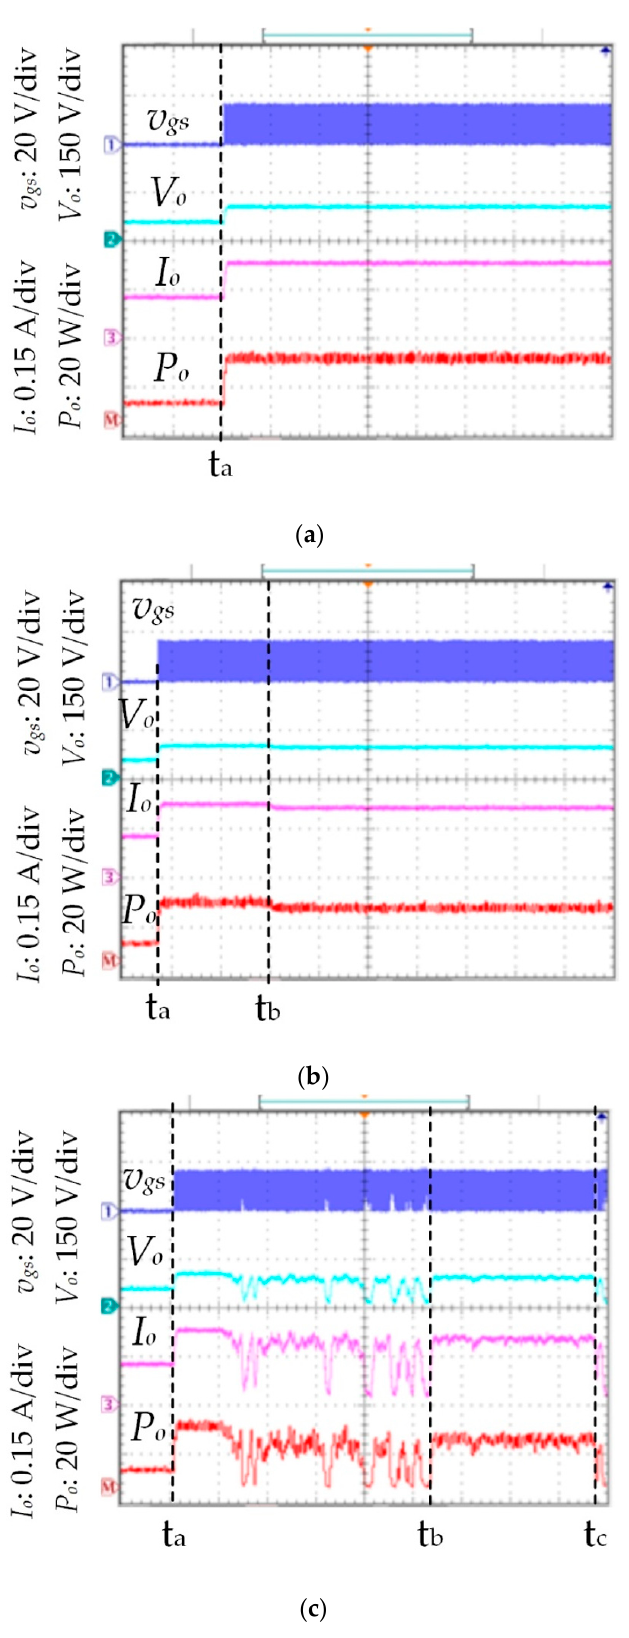
Figure 15. The waveforms of v gs , V o , I o , and P o under UIC at IL = 65 W/m 2 and temperature = 25 °C by implementing the control strategy ( a ) SLOPDM, ( b ) SAH, and ( c ) P&O algorithms. (Horizontal axis: 2 s/div).